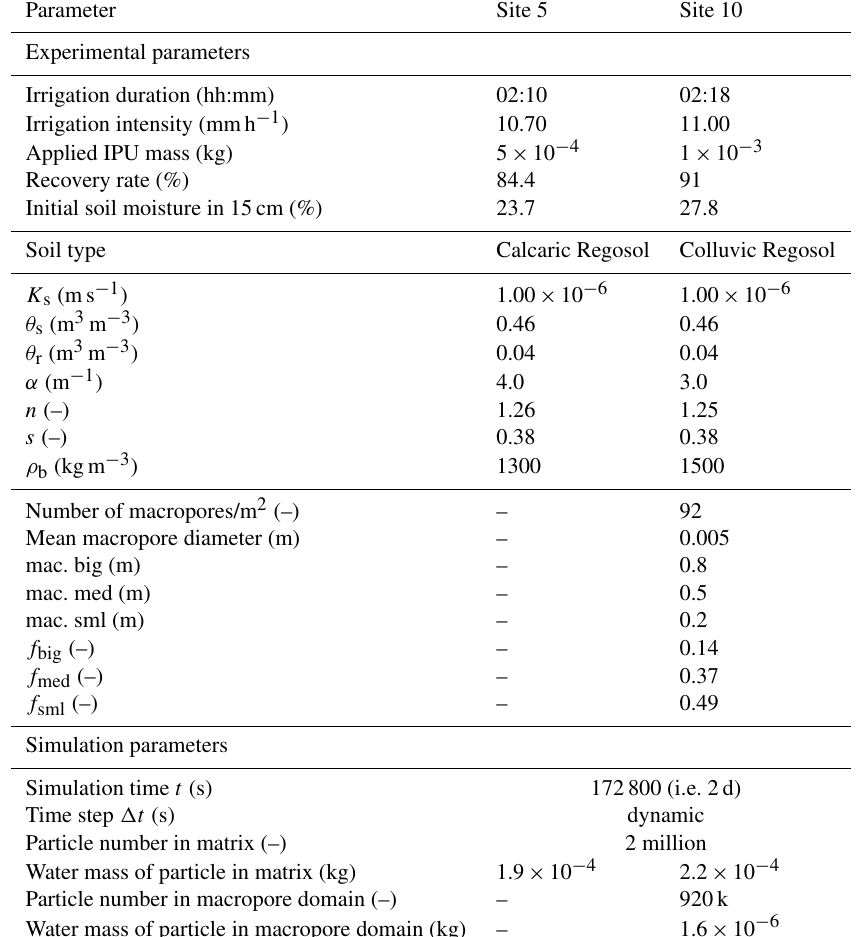
Table 1. Parameters of IPU plot-scale experiments and simulations, as well as soil hydraulic parameters according to van Genuchten (1980) and Mualem (1976), at sites 5 and 10, where K s is the saturated hydraulic conductivity, θ s the saturated soil water content, θ r the residual soil water content, α the inverse of an air entry value, n a quantity characterizing pore size distribution, s the storage coefficient, and ρ b the bulk density. Further, mac. big, mac. med, and mac. sml describe the lengths of big, medium, and small macropores as well as f big , f med , and f sml are the respective distribution factors to split the total number of macropores into these three macropore depths (cf. Sect. 2.2.2). For further details on these parameters, see Sternagel et al.